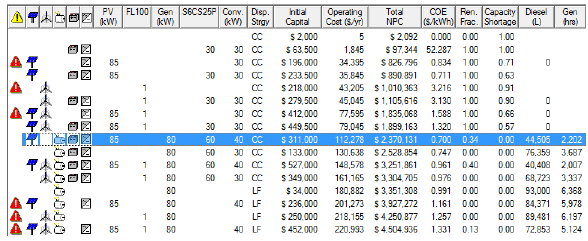
Figure 8: Categorized Optimization Results for Abeokuta